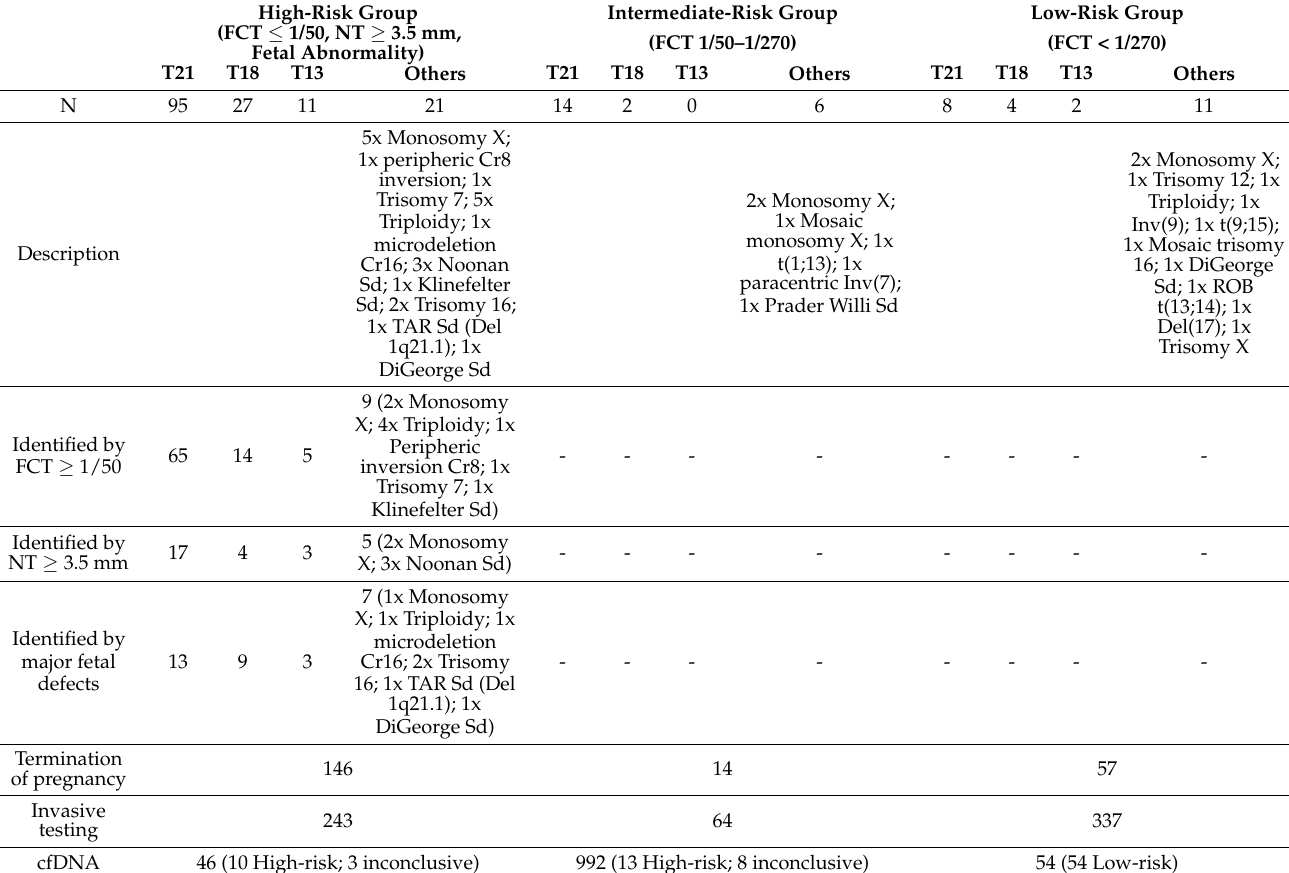
Table 1. Performance of the first-trimester contingent screening with the current